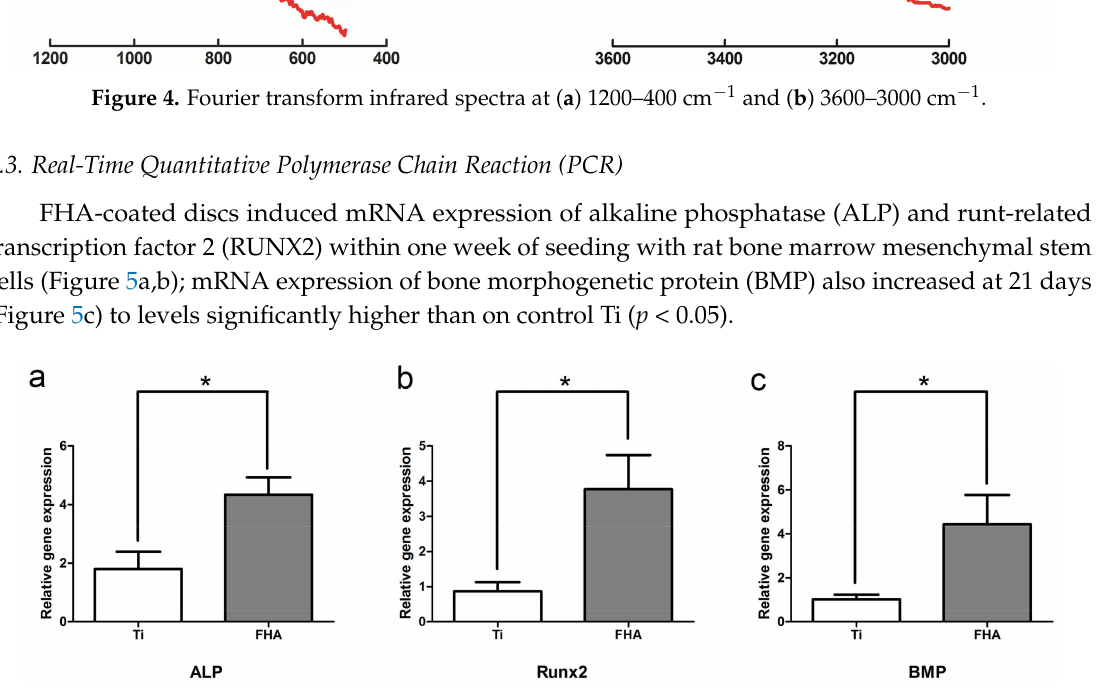
Figure 5. Expression of ( a ) ALP, ( b ) RUNX2, and ( c ) BMP in cells seeded on Ti and FHA-coated discs. * p < 0.05.